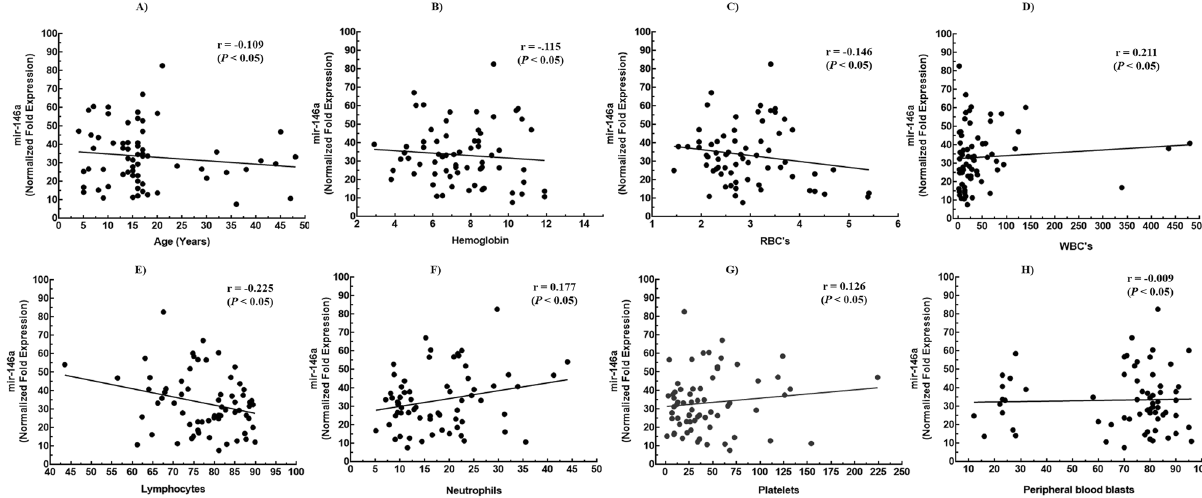
Figure 3. Correlation analysis of plasma mir-146a in ALL. ( A ) Age, ( B ) Hemoglobin, ( C ) RBC’s, ( D ) WBC’s, ( E ) Lymphocytes, ( F ) Neutrophils, ( G ) Platelets, ( H ) Peripheral blood blasts. The expression levels of mir-146a in plasma of ALL patients were not significantly correlated with all the parameters.